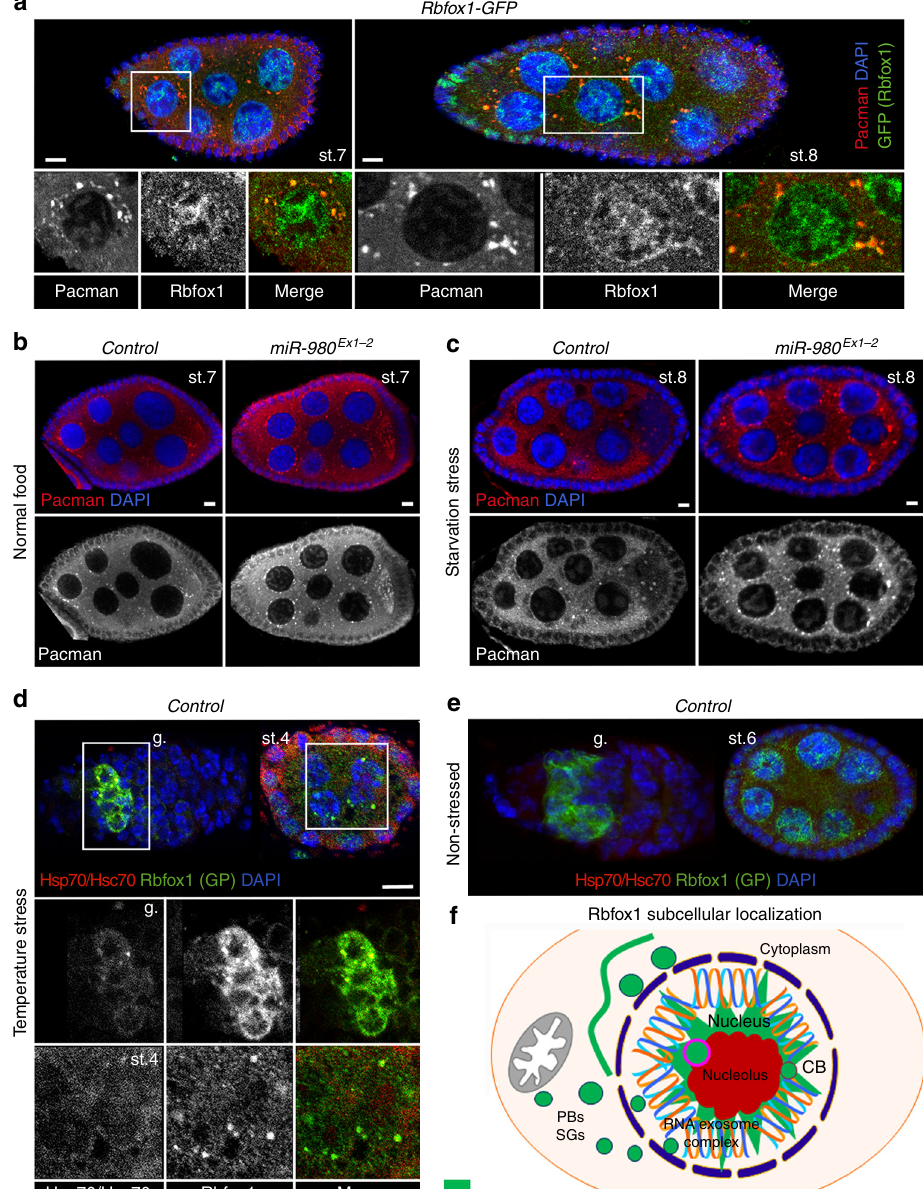
Fig. 6 Rbfox1 colocalizes with P-bodies and stress granules in the cytoplasm. a In the germline, Rbfox1 co-stains with the P-body marker Pacman. Note that all Pacman-positive granules are also Rbfox1-positive, but not all Rbfox1 foci stain with Pacman. b , c Upon miR-980 loss or starvation, which leads to elevated Rbfox1 levels, the appearance of P-bodies increases. d Upon temperature stress, Rbfox1 associates with the stress granules marked with anti- Hsp70/Hsc70 in the germarium and later stage egg chambers (g. and st.6 shown in lower panels). e Stress granules are undetectable in non-stressed ovaries. f Schematic drawing depicts a summary of subcellular localization of Rbfox1 protein. Rbfox1 is associated with the major membraneless organelles that regulate RNA metabolism, such as nucleoli and Cajal bodies in the nucleus and P-bodies, stress granules and amyloid-like fi bers in the cytoplasm. Rbfox1 (green); DAPI (nuclei, blue); Pacman (P-bodies, red); Hsp70/Hsc70 (stress granules, red). Egg chambers are shown in a – e . Developmental stages (st.) of egg chambers are marked, germarium (g.). Images in a – e are single Z-sections. Scale bars 5 µ